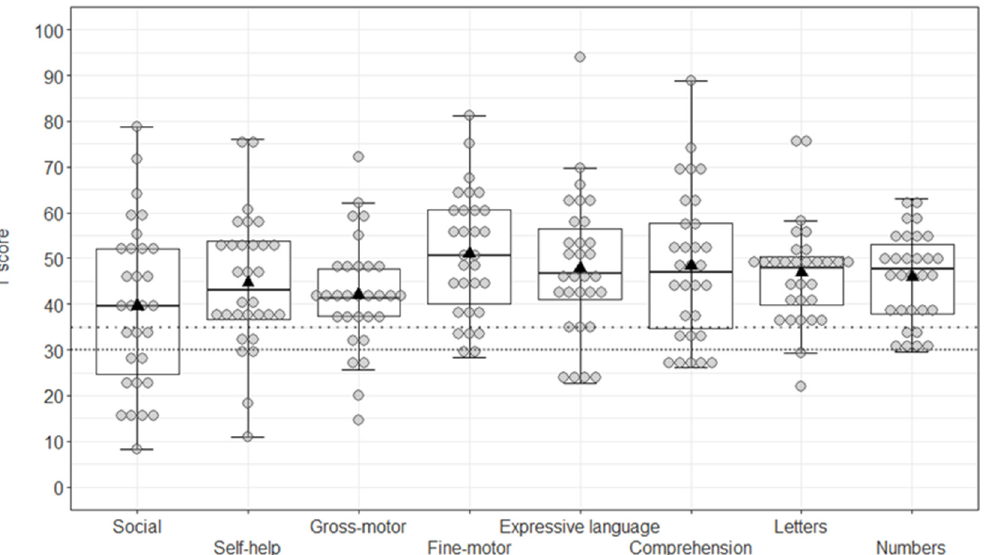
Figure 2. Boxplot of T-scores at the CDI. Grey circles ( ● ) represent individual scores, black triangles ( ▲ ) indicate group mean scores; lines with wide and dense dots show, respectively, the borderline and clinical thresholds.